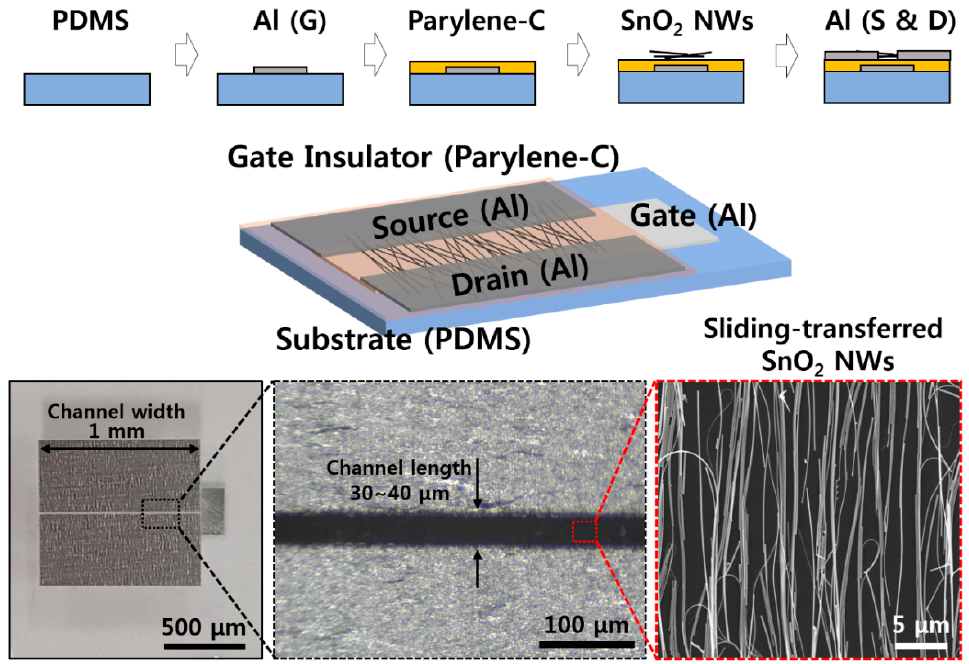
Figure 1. Schematic illustration of fabrication procedure and images of the SnO 2 nanowires (NWs) ff ect transistor (FET) field-effect transistor (FET) device. field-e